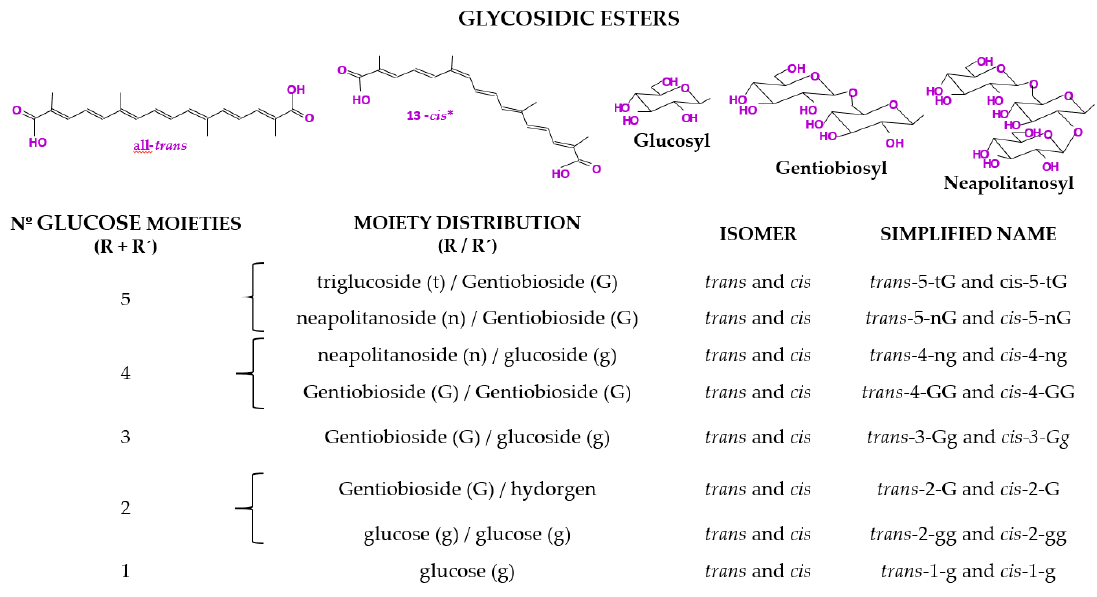
Figure 2. Structure and simplified name of the crocins (glycosidic esters of crocetin) found in saffron [6]. Picrocrocin (4-( β - D -glucopyranosyloxy)-2,6,6-trimethyl-1-cyclohexene-1-carboxaldehyde, C 16 H 26 O 7 )